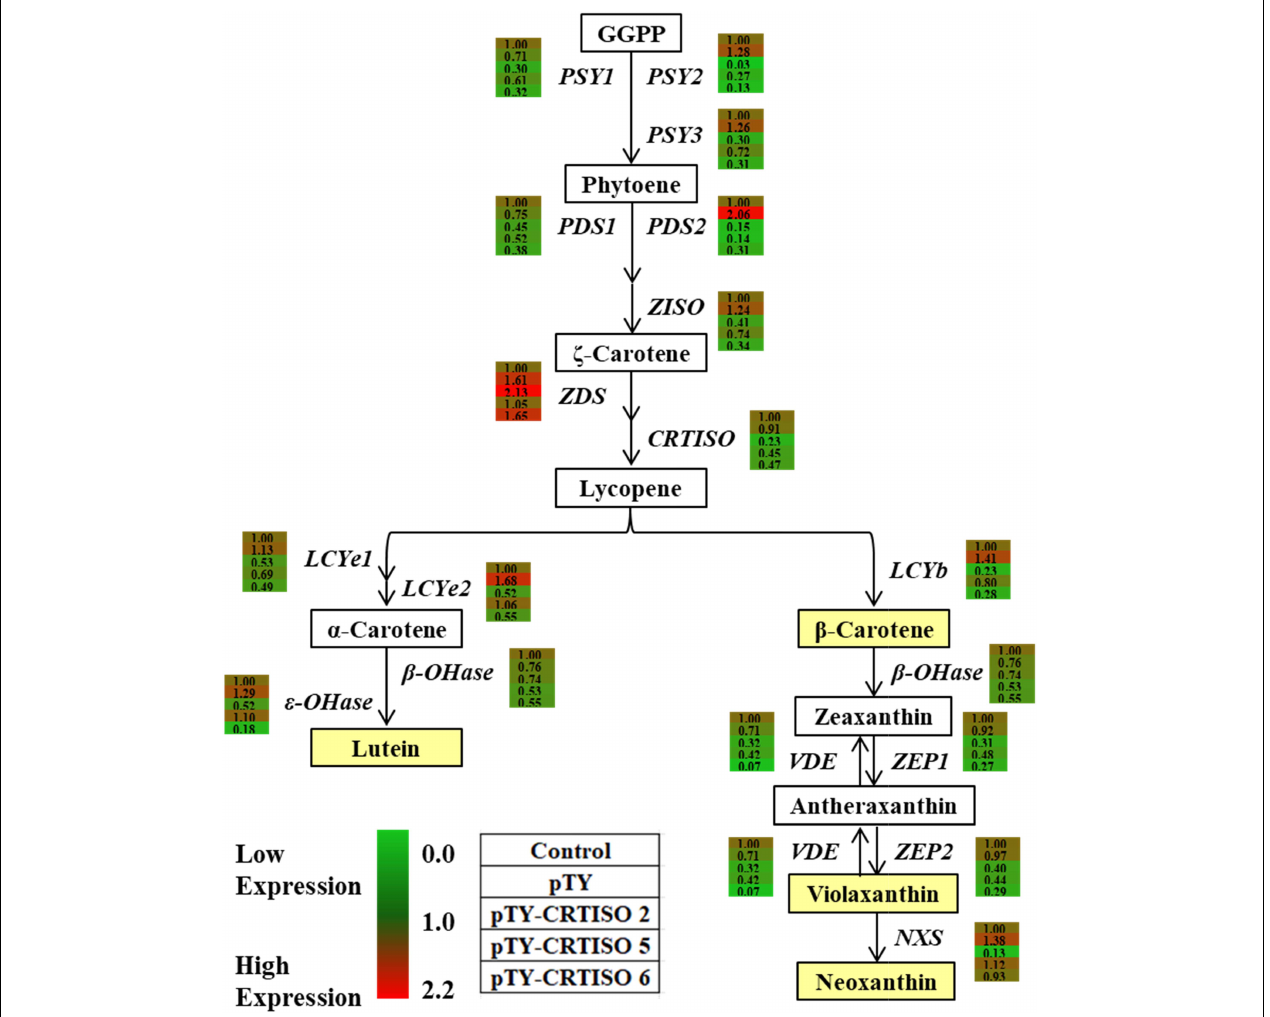
FIGURE 6 | Heat map of carotenoid biosynthetic gene expressions in control, pTY, and pTY-BoaCRTISO plants. Samples of leaves were taken from control, pTY, and pTY-BoaCRTISO plants at 1 week after the last infiltration. GGPP, geranylgeranyl diphosphate; PSY, phytoene synthase; PDS, phytoene desaturase; ZDS, ζ -carotene desaturase; Z-ISO, ζ -carotene isomerase; CRTISO, carotenoid isomerase; LCYe, lycopene ε -cyclase; LCYb, lycopene β -cyclase; ε -OHase, ε -carotene hydroxylase; β -OHase, β -carotene hydroxylase; VDE, violaxanthin de-epoxidase; ZEP, zeaxanthin epoxidase; NXS, neoxanthin